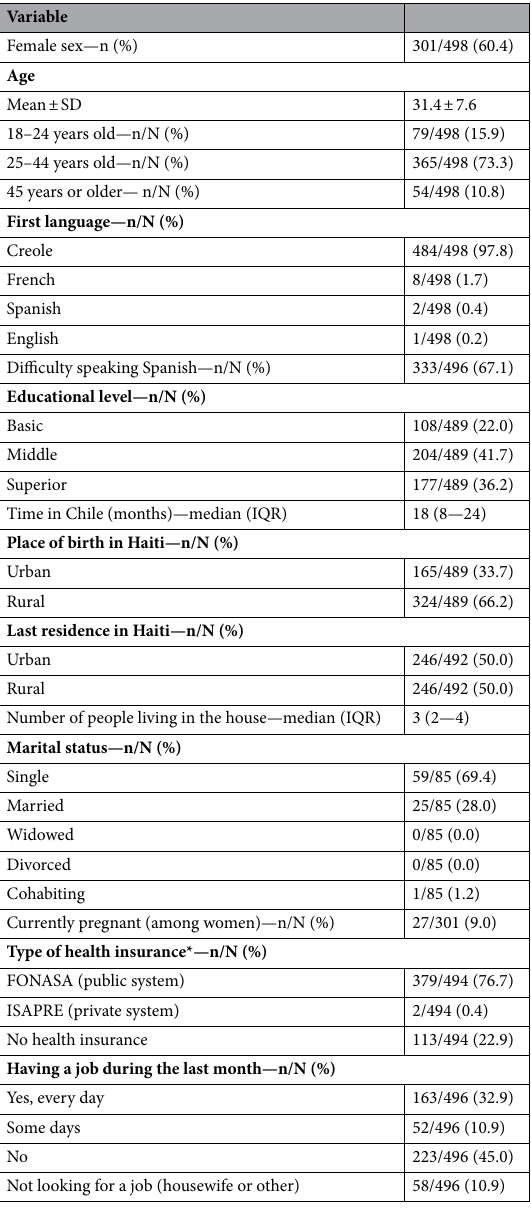
Table 1. Socio-demographic characteristics of subjects. SD: Standard deviation, IQR: Interquartile range. *FONASA: Fondo Nacional de Salud. ISAPRE: Institución de Salud